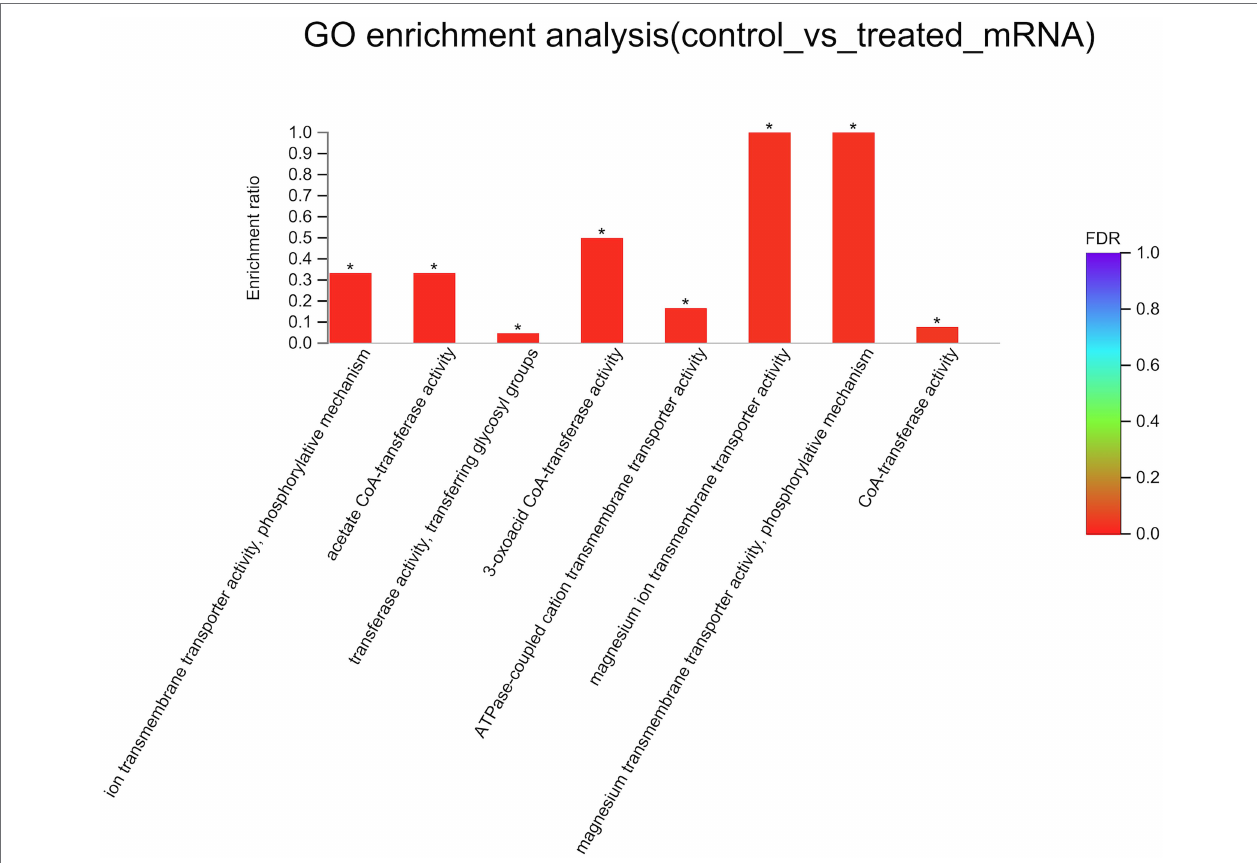
FIGURE 7 | GO enrichment analysis of differentially expressed genes. The x -axis represents GO terms, and the y -axis represents the enrichment ratio. A higher ratio means a greater degree of enrichment. GO, Gene Ontology; FDR , false discovery rate. * FDR < 0.05 .